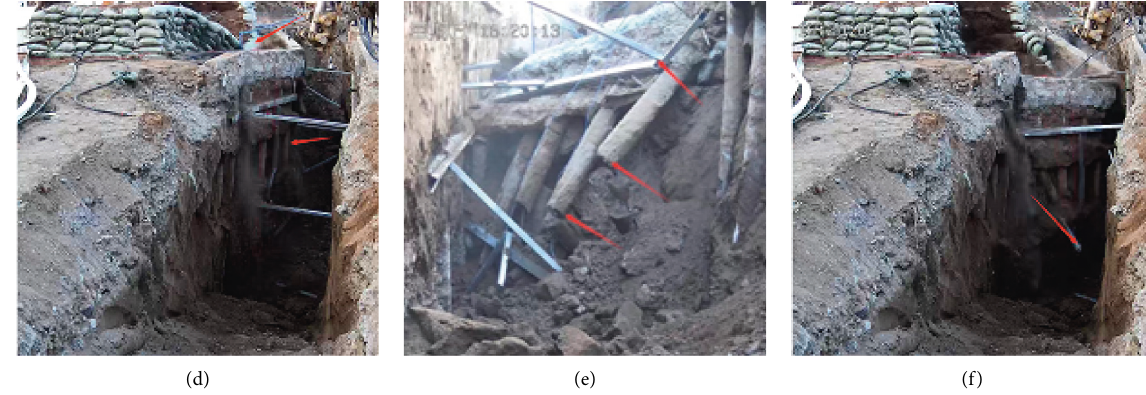
Figure 14: The collapse process of the foundation pit. (a) Small soil blocks on the side wall fall. (b) Many soil blocks on the side wall fell. (c) The middle of the foundation pit begins to topple (north view). (d) The middle of the foundation pit begins to topple (south view). (e) The waist beam on the second floor on the north side fell. (f) Falling failure of second floor